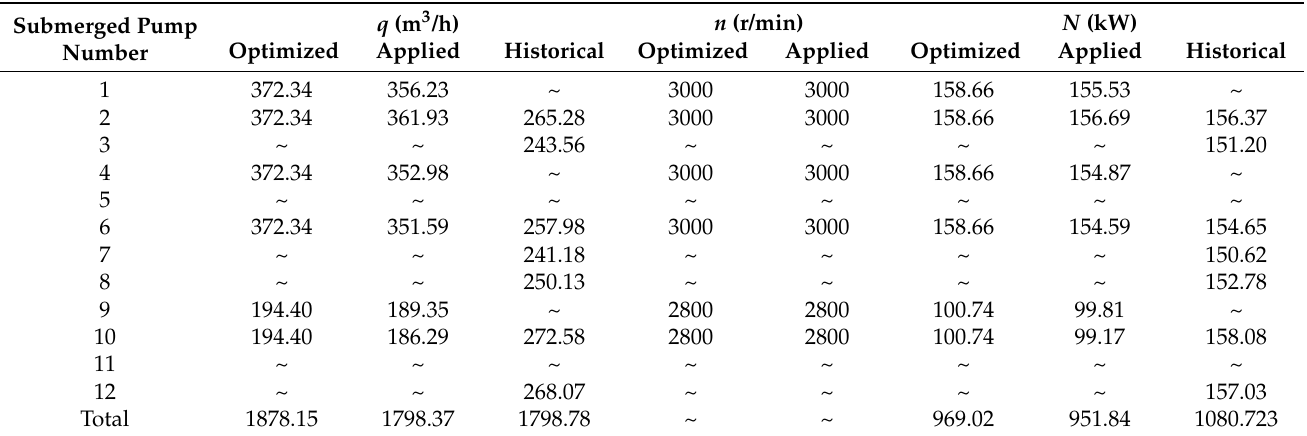
Table 5. Model optimization and field application